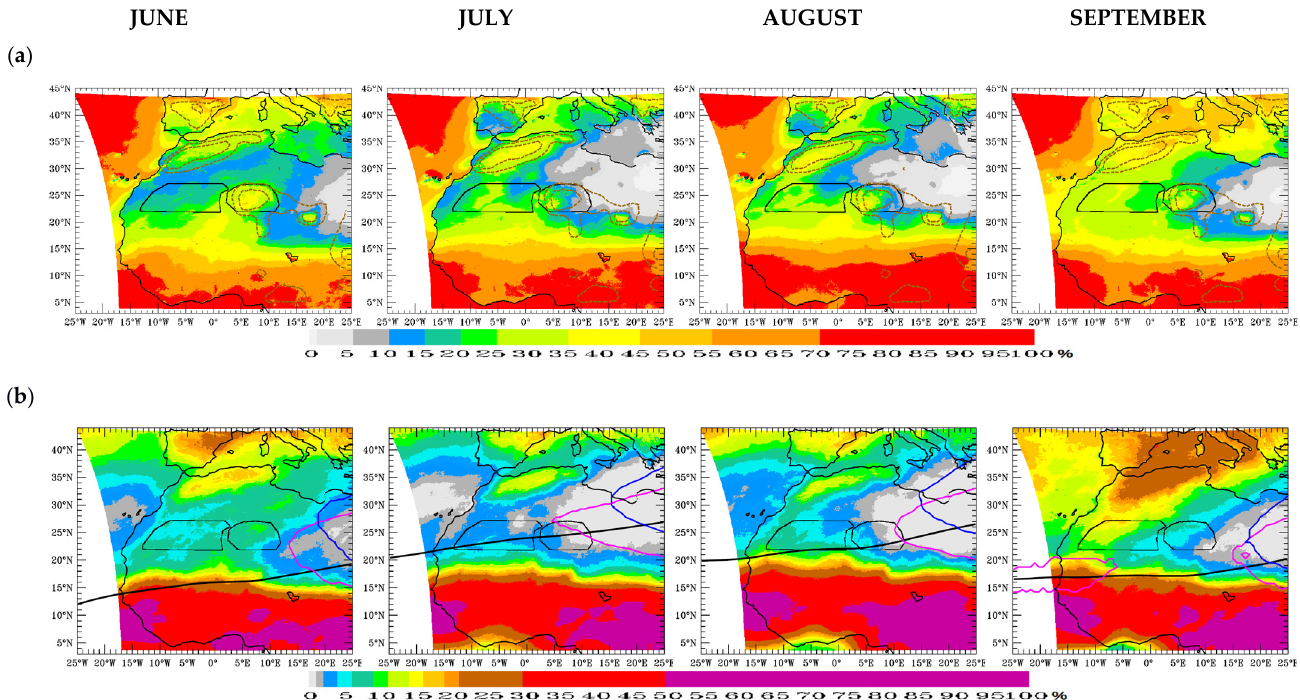
Figure 2. ( a ) Total cloud cover occurrence frequencies (COF, shadings), together with 650 m and 1000 m topography isolines (brown dashed contours). ( b ) High-top COF (shadings), zero isoline of the zonal wind at 200 hPa (black), boundaries of the most frequent regions for the maximum of geopotential height at 200 hPa and 100 hPa (pink and blue contours, respectively).